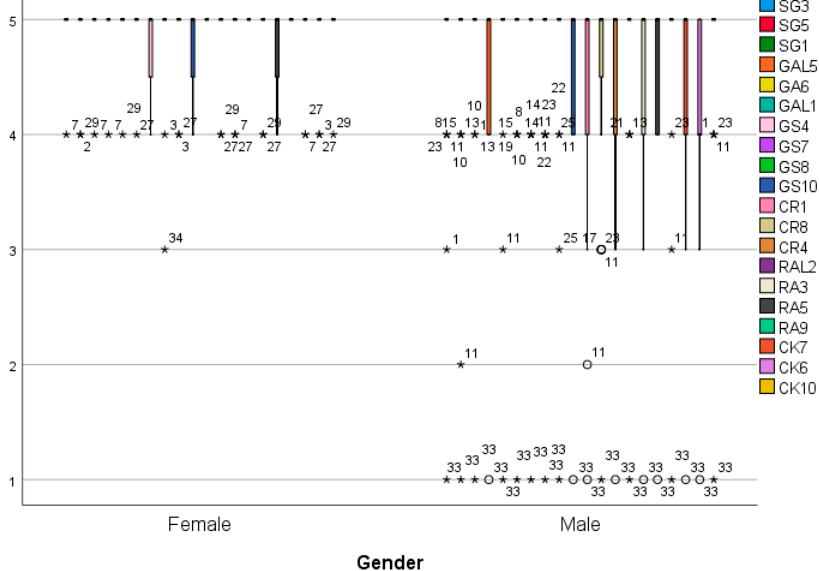
Figure A1. Gender disaggregated boxplot chart histograms.